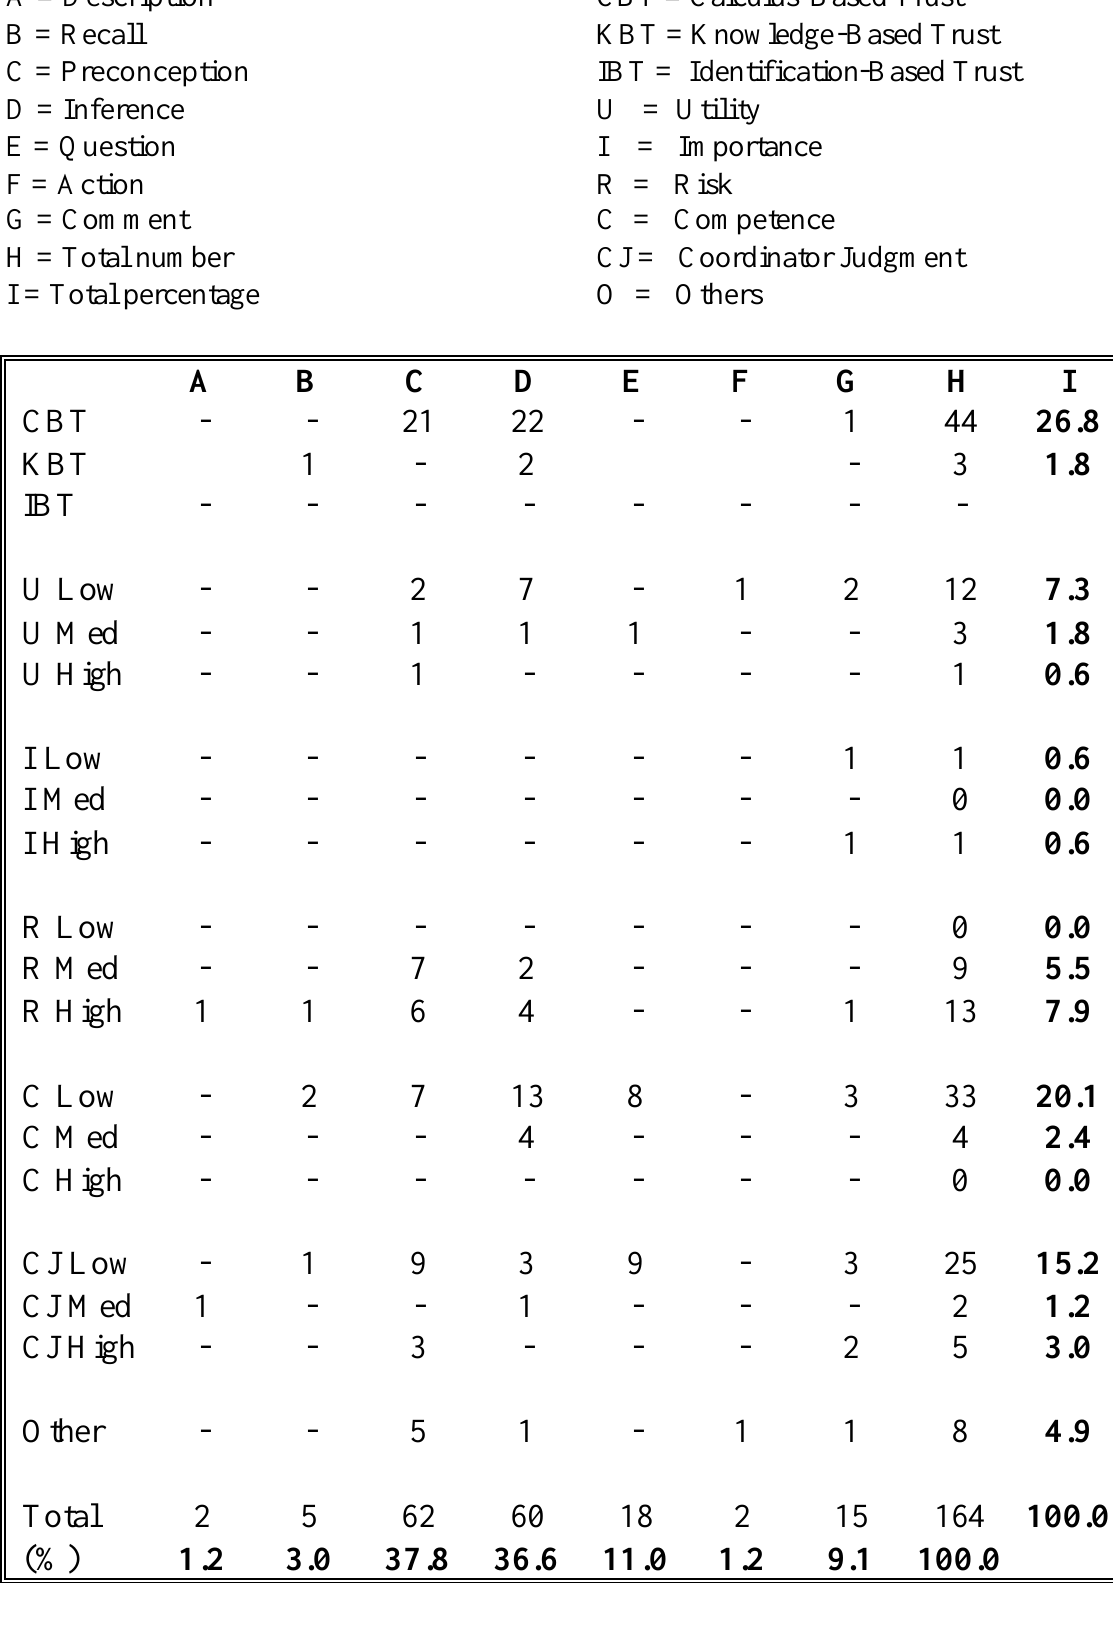
Verbal protocol frequency analysis for 30